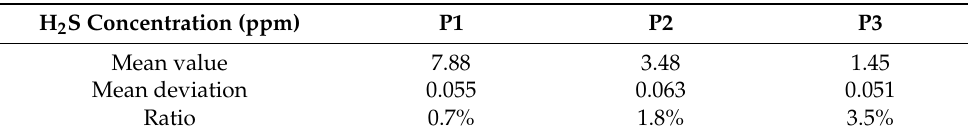
Figure 4. H 2 S concentration at P1, P2, and P3 (0 m, 4 m, 11 m), with the temperature change (from 288 K to 303 K). The wind speed was constant at 4 m/s. Table 3. Mean value, mean deviation, and ratio of mean deviation to mean value of H 2 S concentration with different temperatures at P1, P2, and P3.